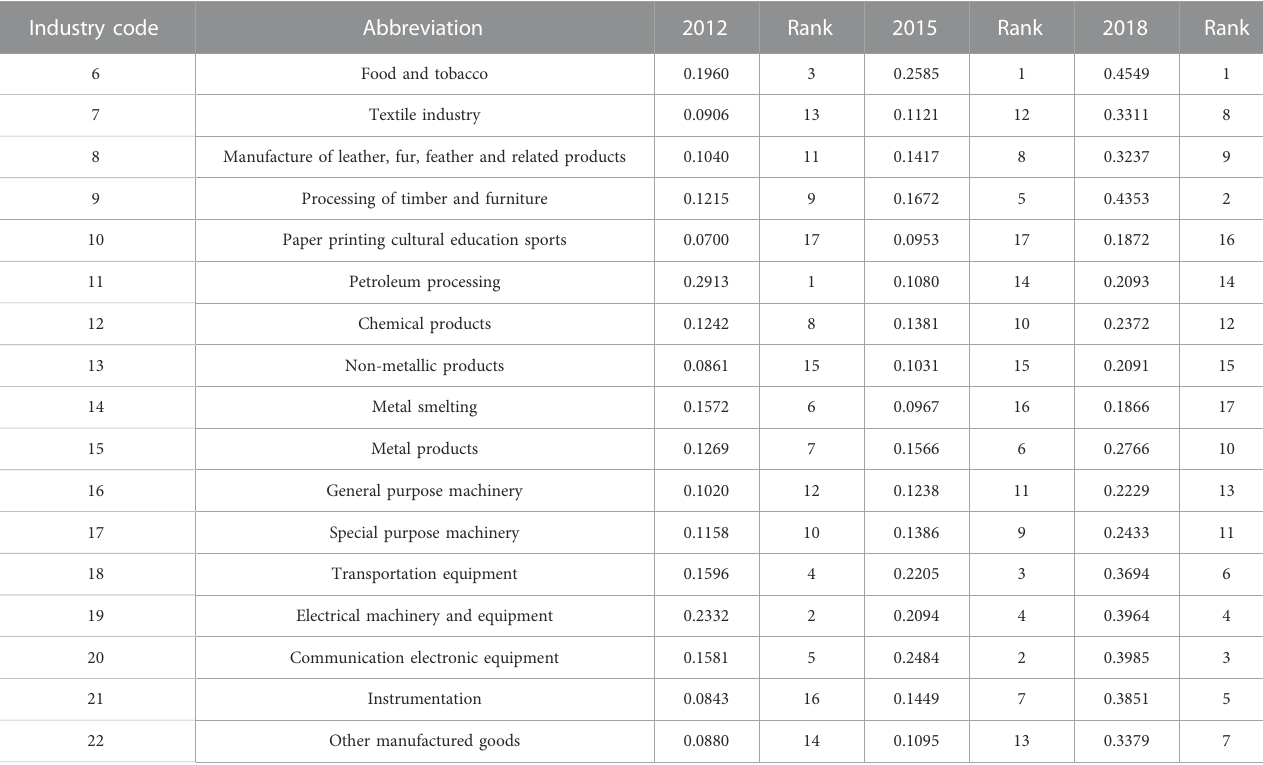
TABLE 1 Measurement results of low-carbon development level of manufacturing industry. Industry